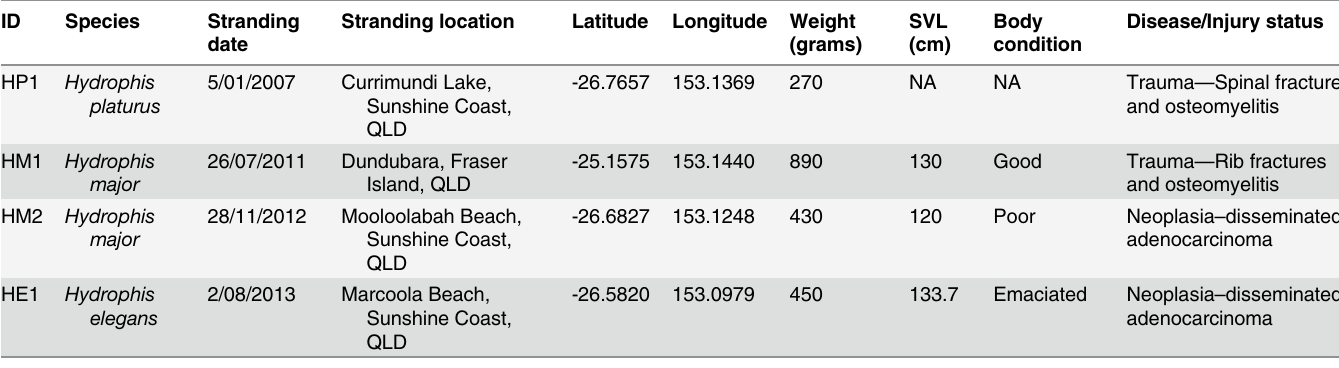
Table 1. Case details for sea snakes affected by